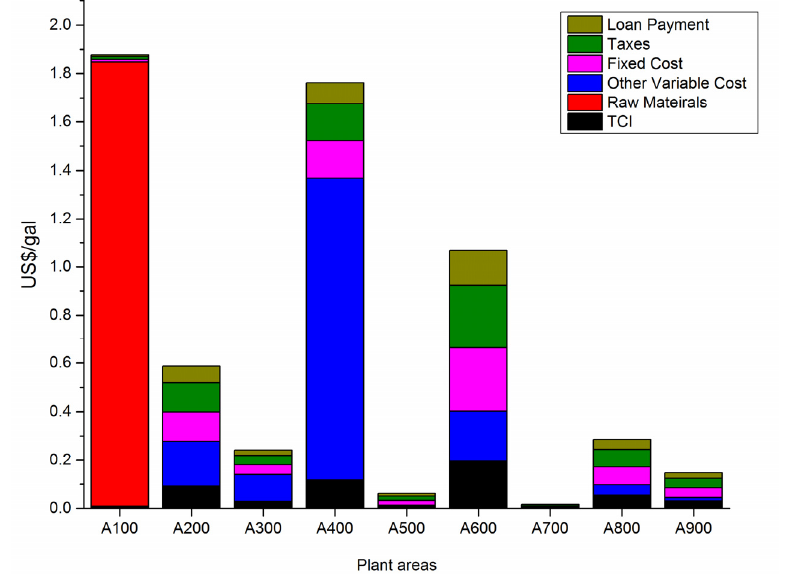
Figure 5. Cost breakdown of plant areas in scenario CN_1.